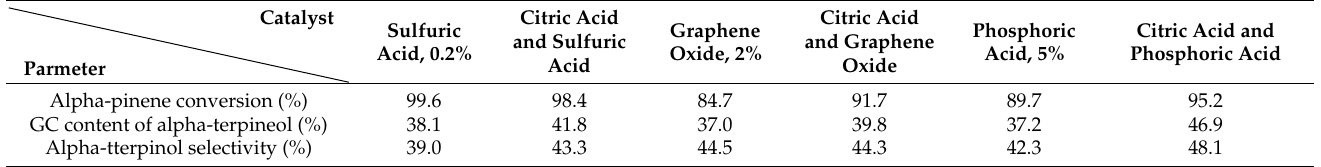
Table 7. Effects of inorganic acids on hydration of